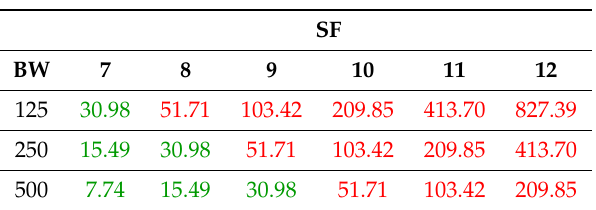
Table 10. Values of T packet in ms depending on BW and SF, with CR = 1, CRC disabled, and implicit header. The red color indicates values of the table that are not feasible. The green color indicates values of the table that are